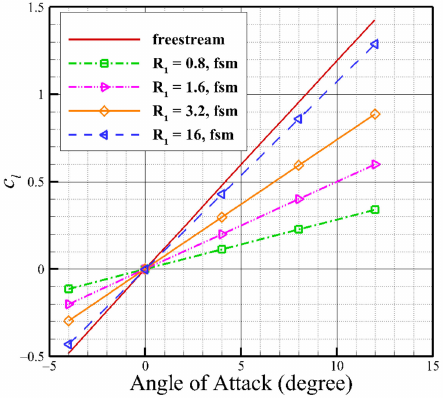
Figure 15. Comparison of lift coefficients vs. α at different height-chord ratios.